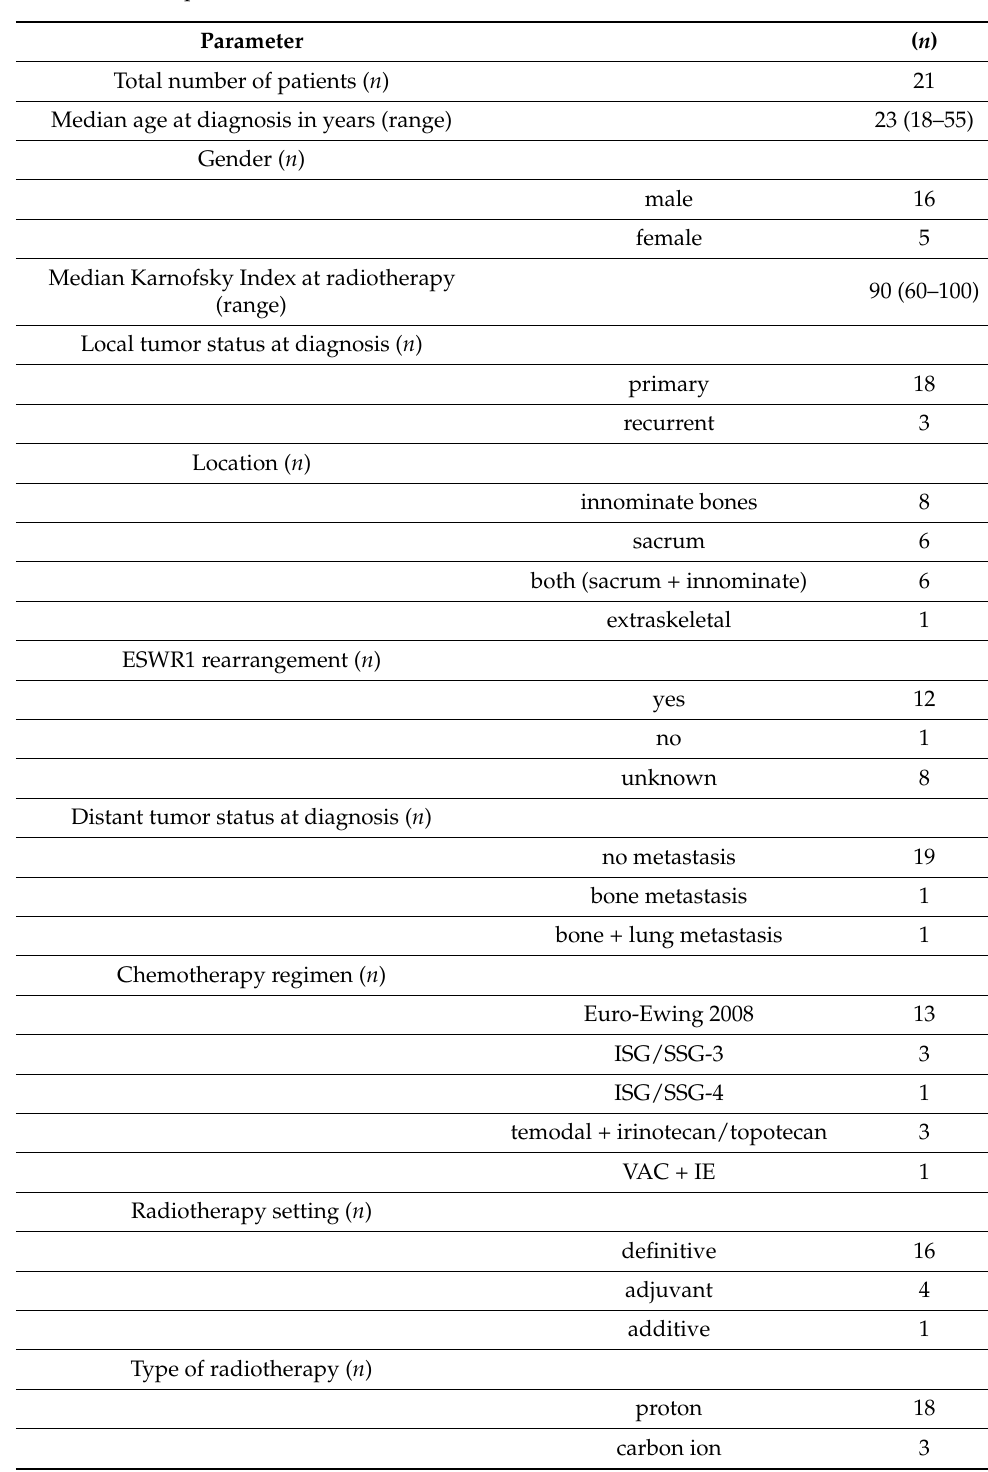
Table 1. General patient, tumor and treatment